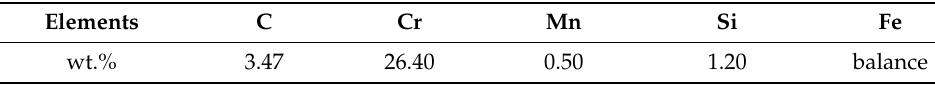
Table 1. The chemical composition of the HCCI (wt.%).